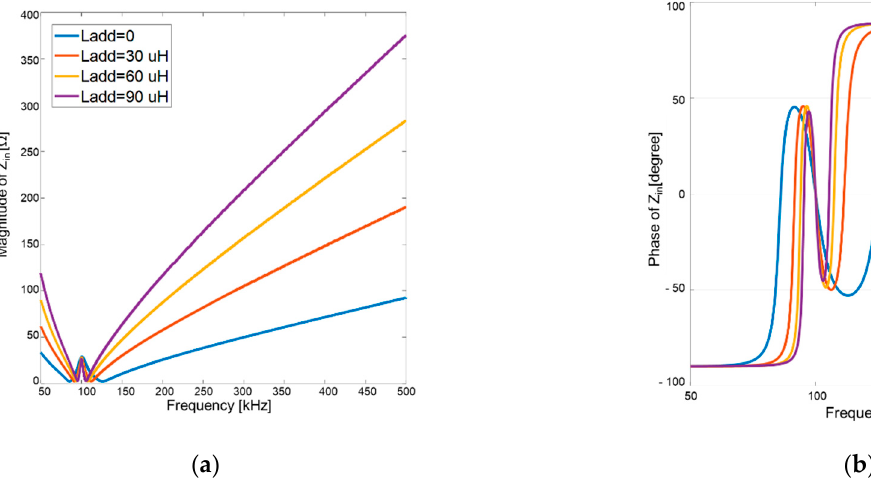
Figure 27. Input impedance change according to the series inductance value (L add-tx , L add-rx ) when resonance frequency is 100 kHz: ( a ) input impedance magnitude change according to frequency change; ( b ) input impedance phase change according to frequency change.